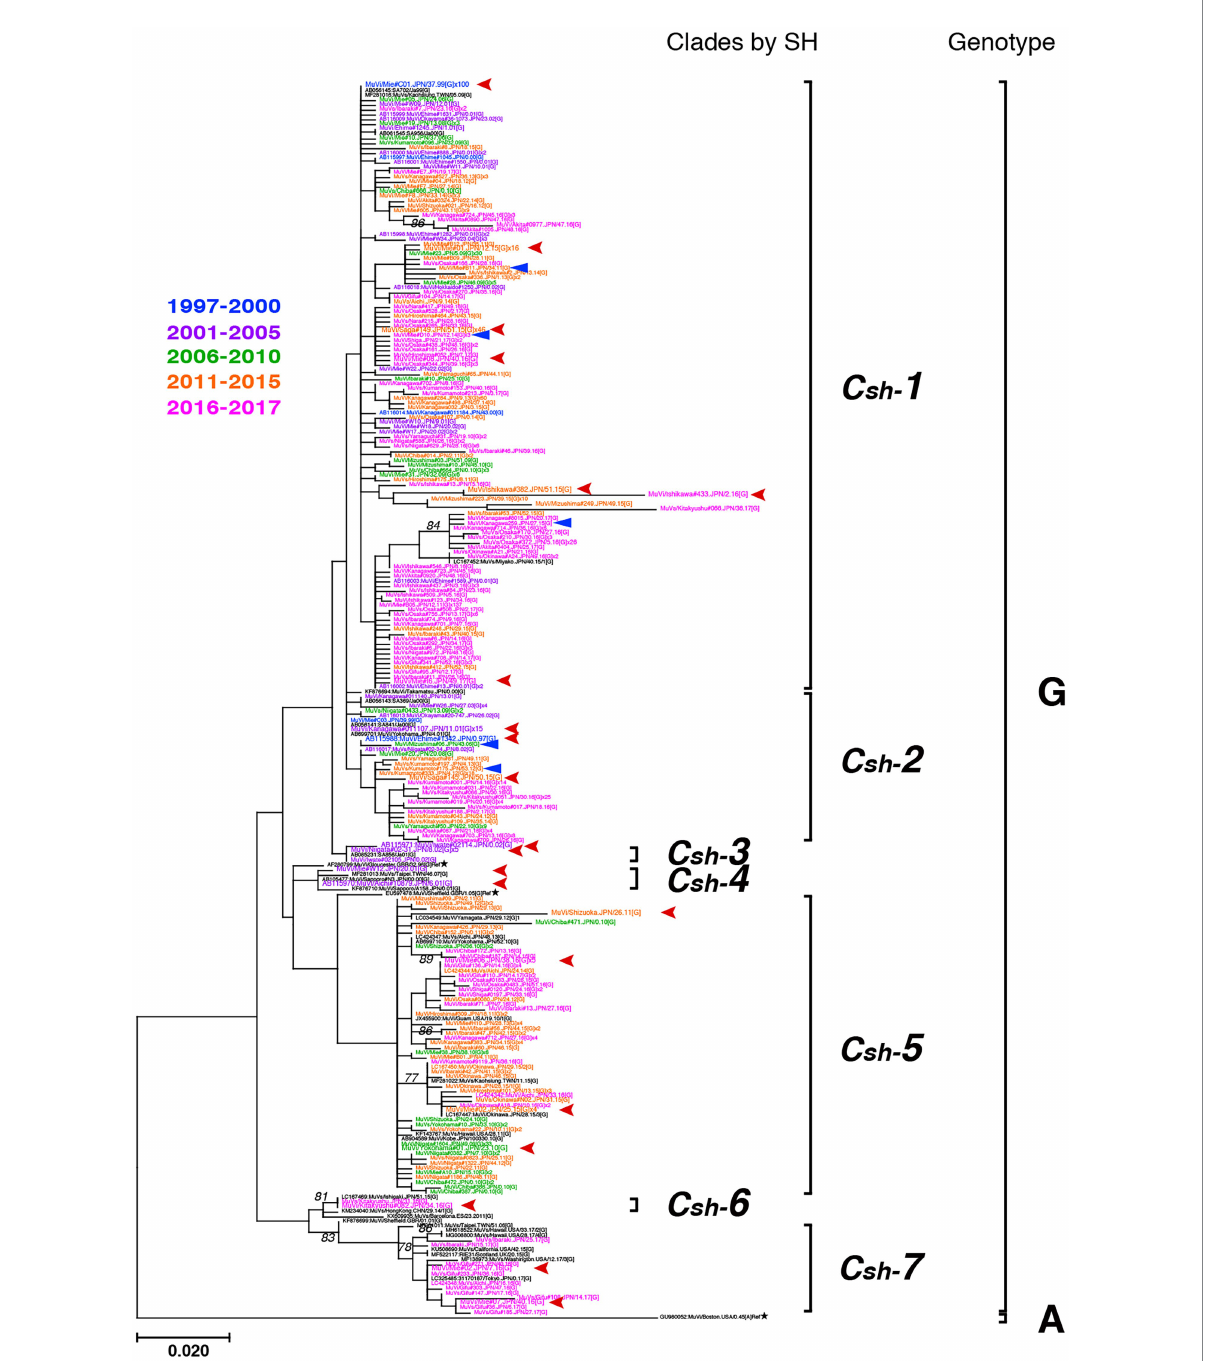
FIGURE 6 Maximum-likelihood phylogenetic tree of the genotype G strains based on the SH gene sequences. The World Health Organization (WHO) reference strains are indicated by stars ( ★ ). The related strains obtained from the DNA Data Bank of Japan (DDBJ) are indicated in black letters. The strains collected in this study are color coded according to isolated years (1997–2000 in blue, 2001–2005 in purple, 2006–2010 in green, 2011–2015 in orange, and 2016–2017 in magenta). Blue arrow-heads denote the strains harboring the truncated form SH genes. Red arrow-heads denote the strains applied to whole-genome sequencing (WGS) using next-generation sequencing (NGS), which represent each